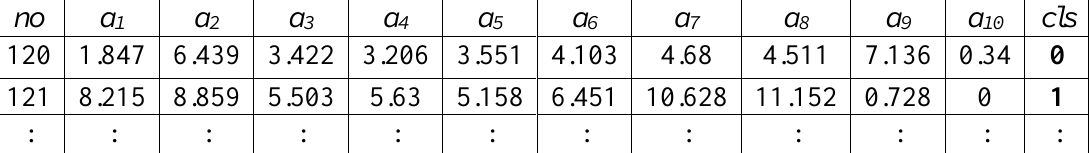
Table 2. Transfer the sensor log data into training